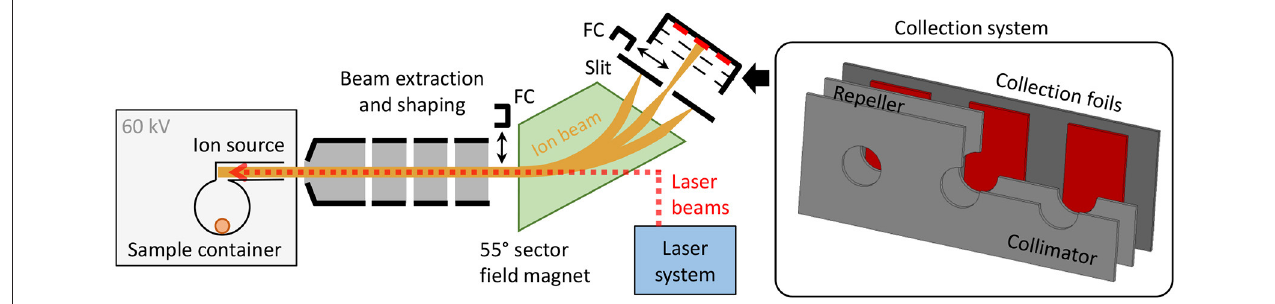
FIGURE 1 | Schematic overview of the MEDICIS mass separator. The inset on the right-hand side schematically depicts a cut view of the actuatable collection system including the sample collection